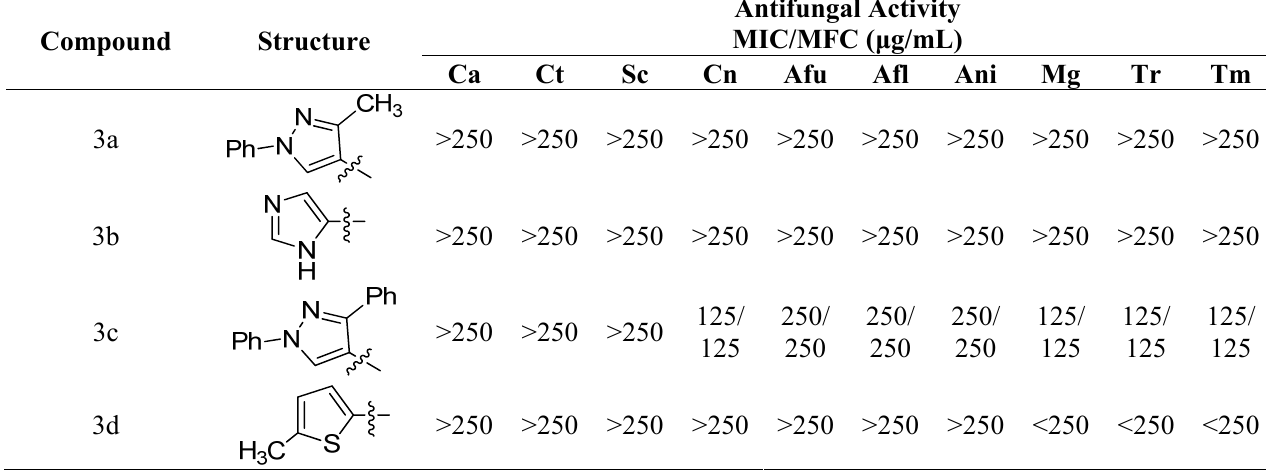
Table 3. In vitro antifungal activities (MIC and MFC values in μ g/mL, showed as MIC/MFC) of hetarylidenerhodanine